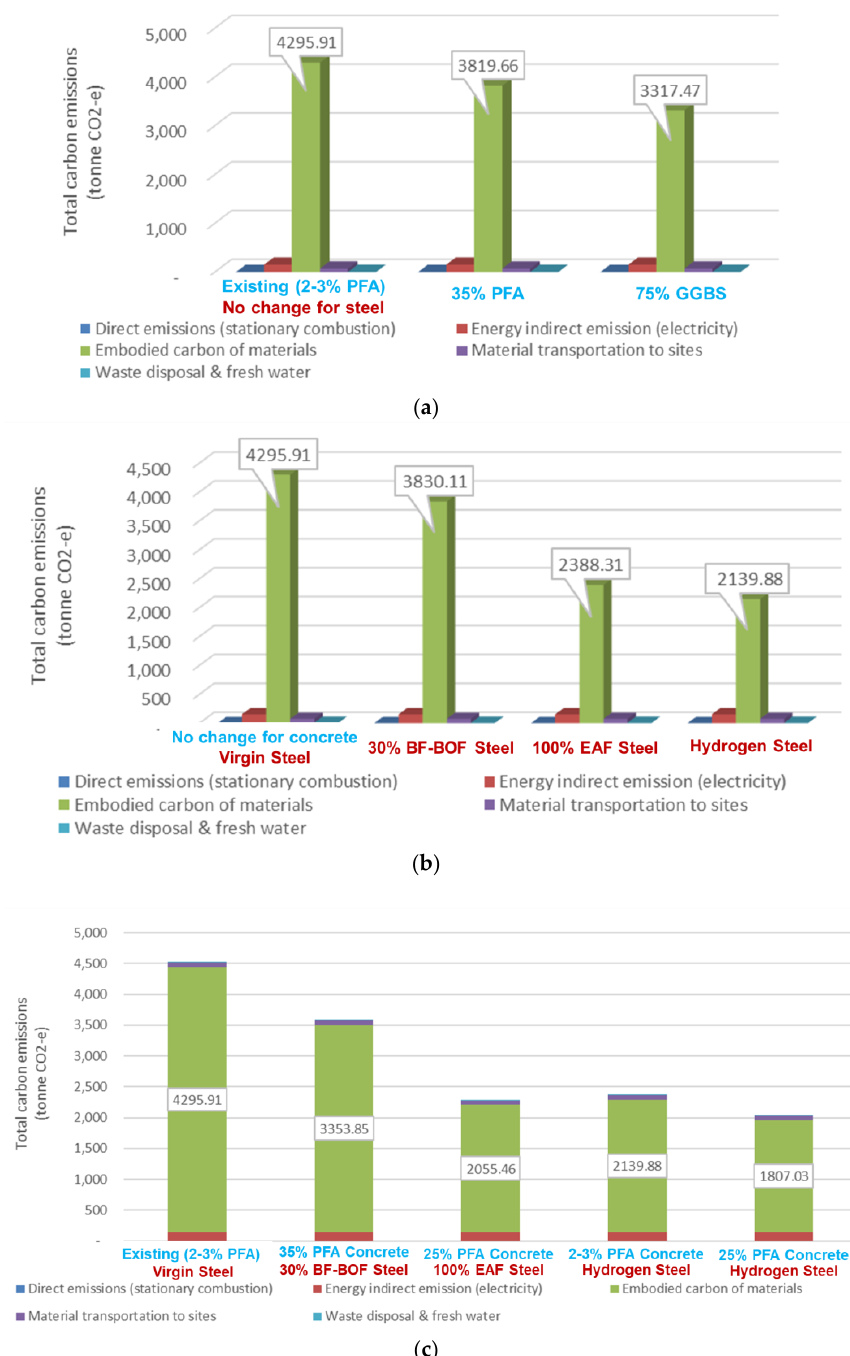
Figure 11. Impacts of cement substitutes, steel scraps, and green hydrogen steel. ( a ) Impact of cement substitutes on upfront embodied carbon. ( b ) Impact of steel scraps and green hydrogen steel on upfront embodied carbon. ( c ) Impact of combined use of low-carbon materials on upfront embodied carbon.